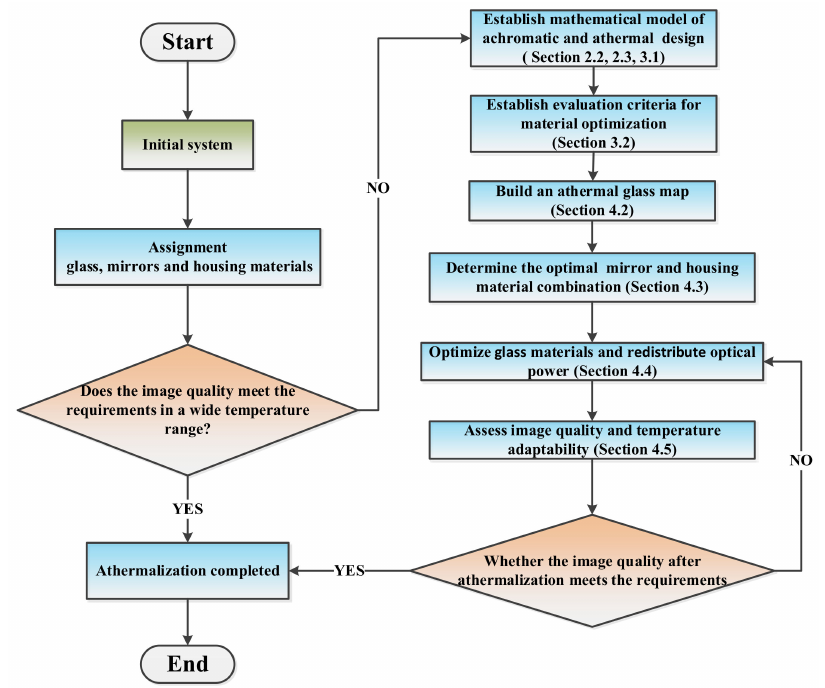
Figure 1. Flow chart of athermal design for catadioptric optical